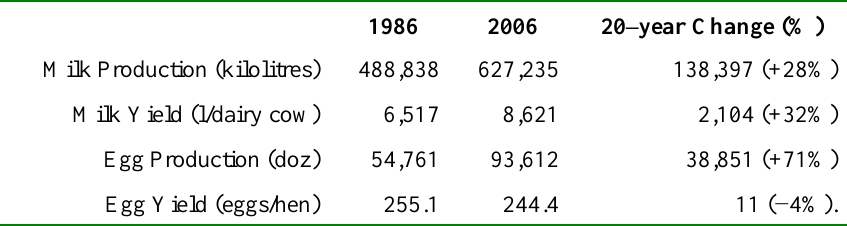
Table 3. Production of Dairy & Eggs in BC,